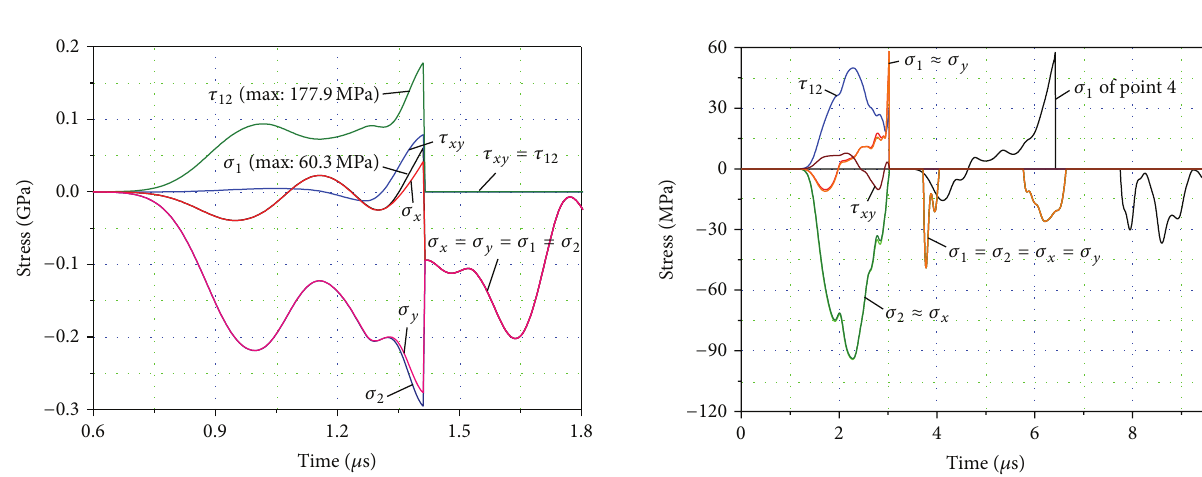
Figure 8: Stresses change of the element containing point